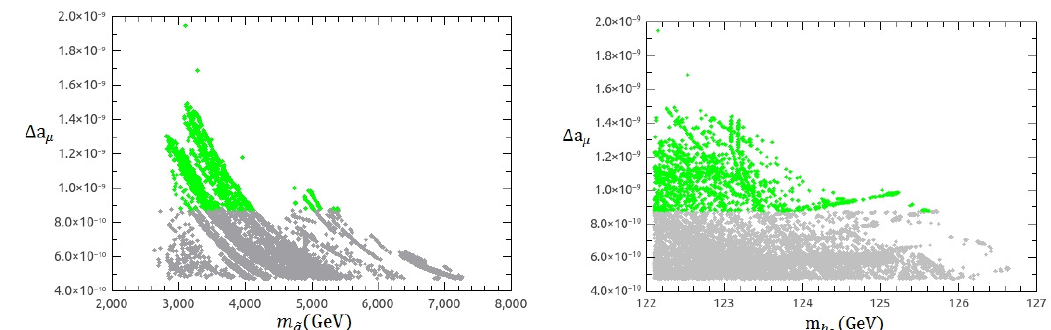
Figure 2 . The scattering plots of survived points for SUSY contributions to muon g-2 anomaly (cid:1) a (cid:22) versus the gluino mass m ~ g (left plot) and the SM-like Higgs mass m h points satisfy the 2 (cid:27) (3 (cid:27) ) range of the muon g-2 anomaly. All survived points satisfy the LHC